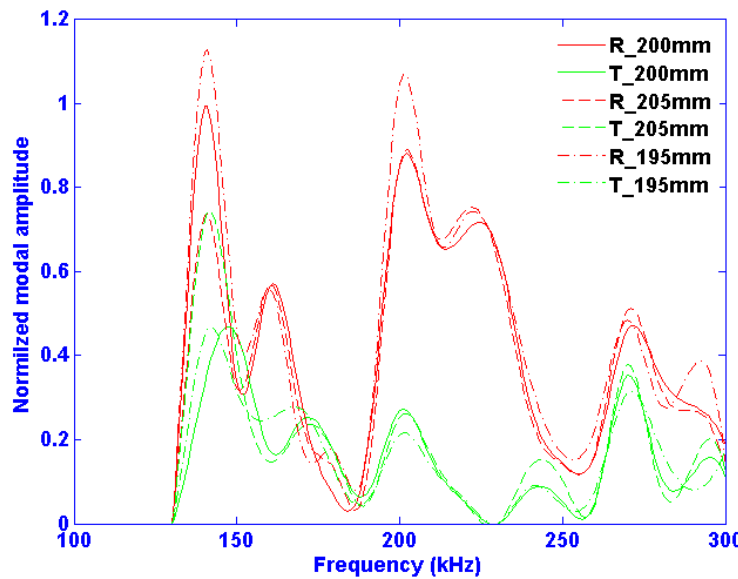
Figure 9. Same title as Figure 8 left but for different distances between the emitter and the crack (i.e., 195, 200 and 205 mm). R and T denote the reflected and the transmitted fields, respectively. At 140 kHz, all three cases are roughly 90 degrees (corresponding to a quarter wavelength) out of phase. The amplitude differences of 30% of these three cases are decidedly larger than at 200 kHz.